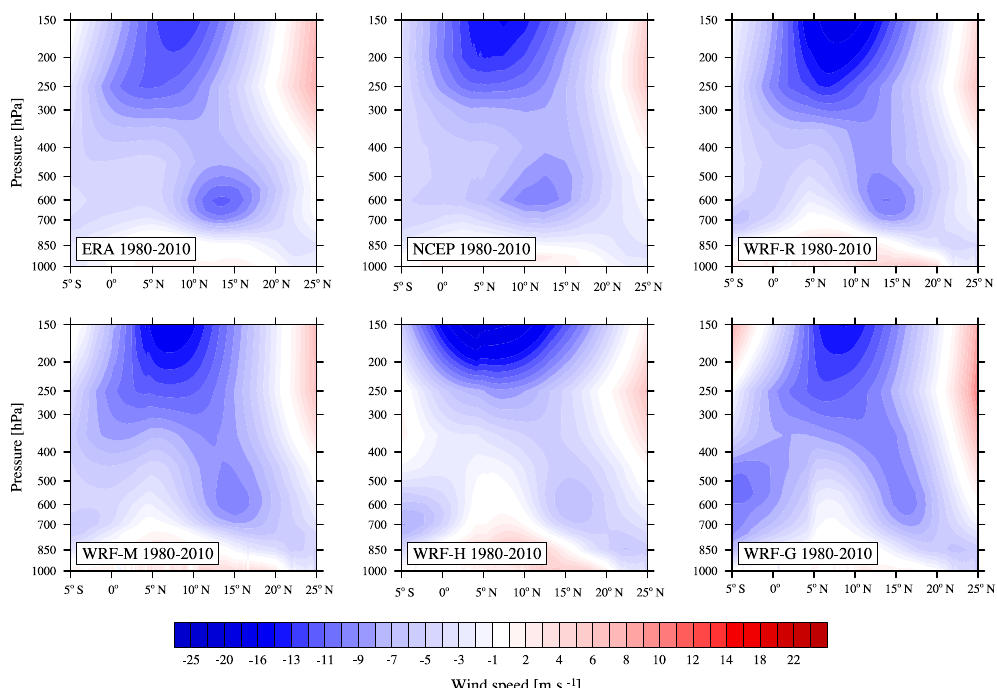
Figure 6. Seasonal (June–July–August) mean zonal wind cross section, averaged between 25 ◦ E and 25 ◦ W for the historical period 1980– 2010 for ERA-Interim and NCEP reanalysis data and the four 12km WRF runs WRF-R, WRF-M, WRF-H and WRF-G.